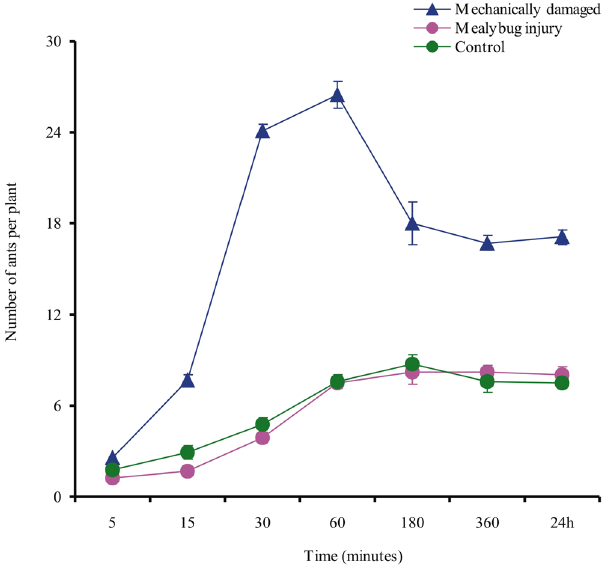
Figure 3. Ant responses to mechanically damaged and mealybug-infested cotton leaves (experiment 3). For mechanical damage, two holes were punched in each of two leaves per plant. For mealybug damage, 60 mealybugs were added per plant. As in experiment 2, the plants were placed on a rack sitting in a box with ca. 200 ants; the ants in the box could move up the rack to the plants but could not contact the leaves because the petioles were coated with petrolatum. Ant numbers per plant were recorded after 5 to 360 min and again after 24 h. Values are the means ( ± SE) of 10